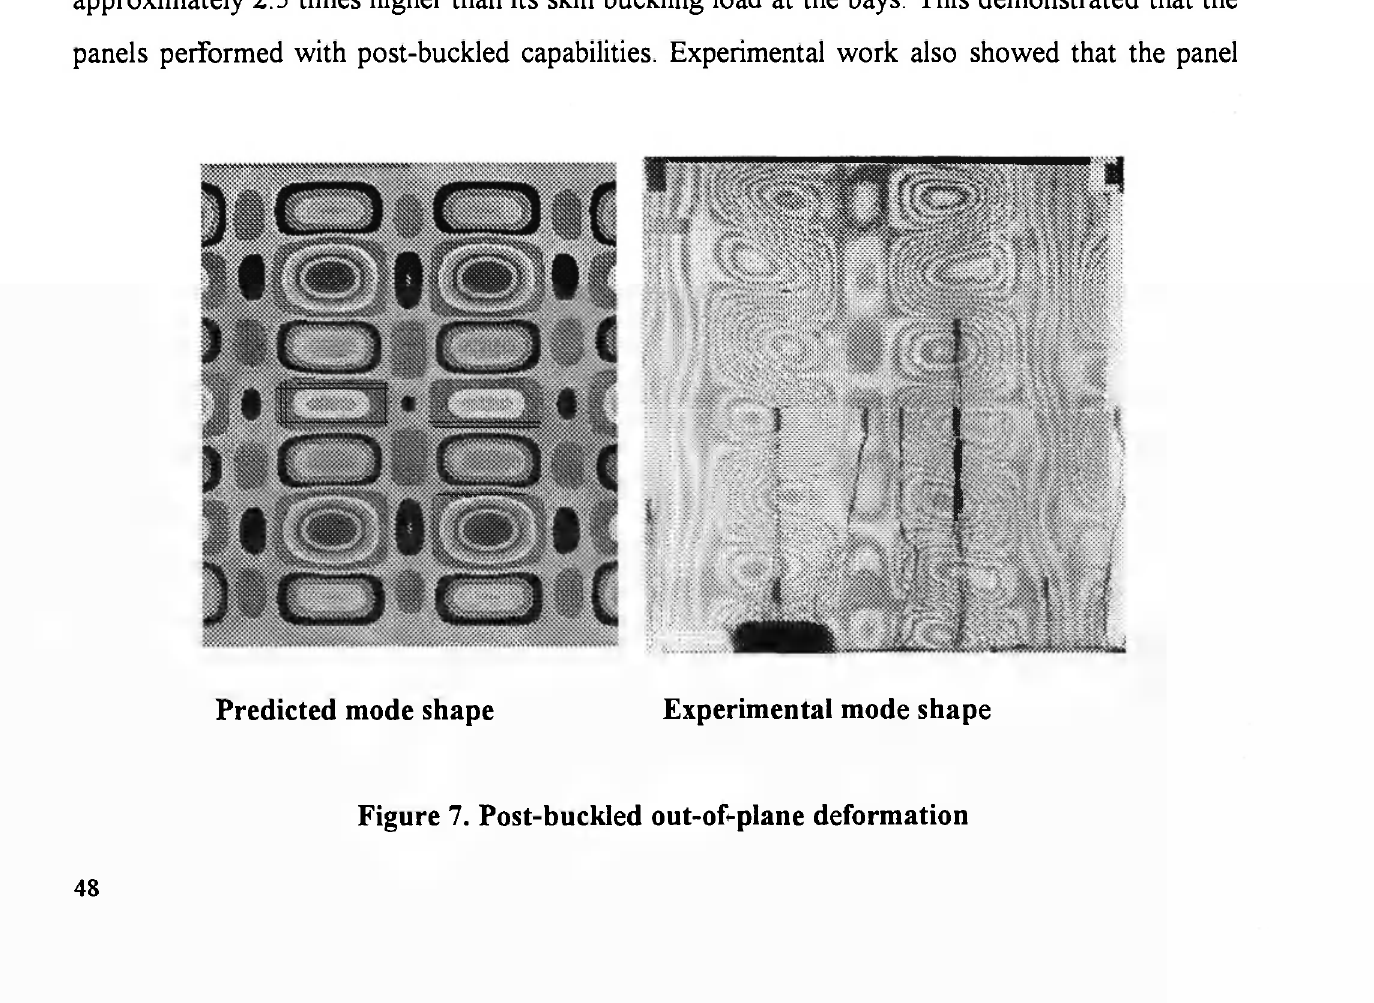
Figure 7. Post-buckled out-of-plane